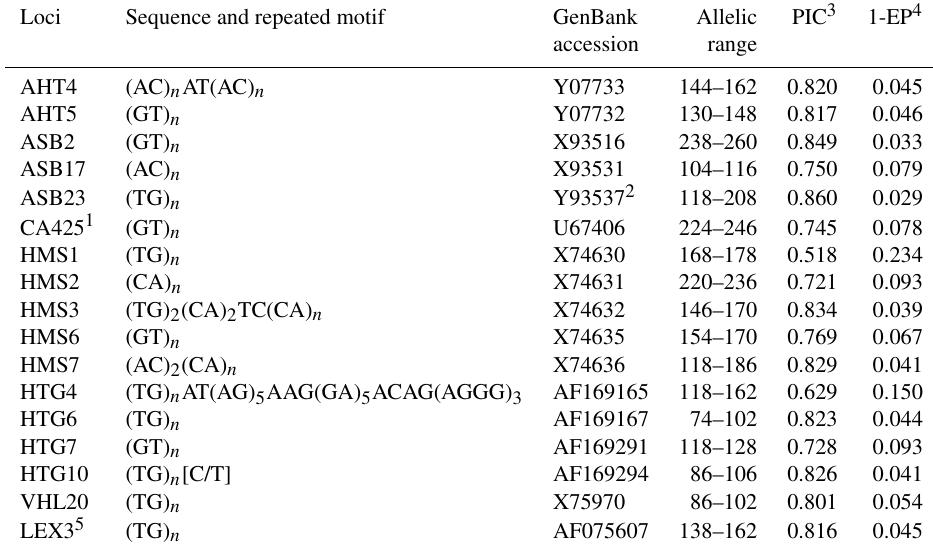
Table 1. Microsatellite panel recommended by ISAG and used for genetic analysis of four horse breeds in South-Central Mexico. Loci Sequence and repeated motif